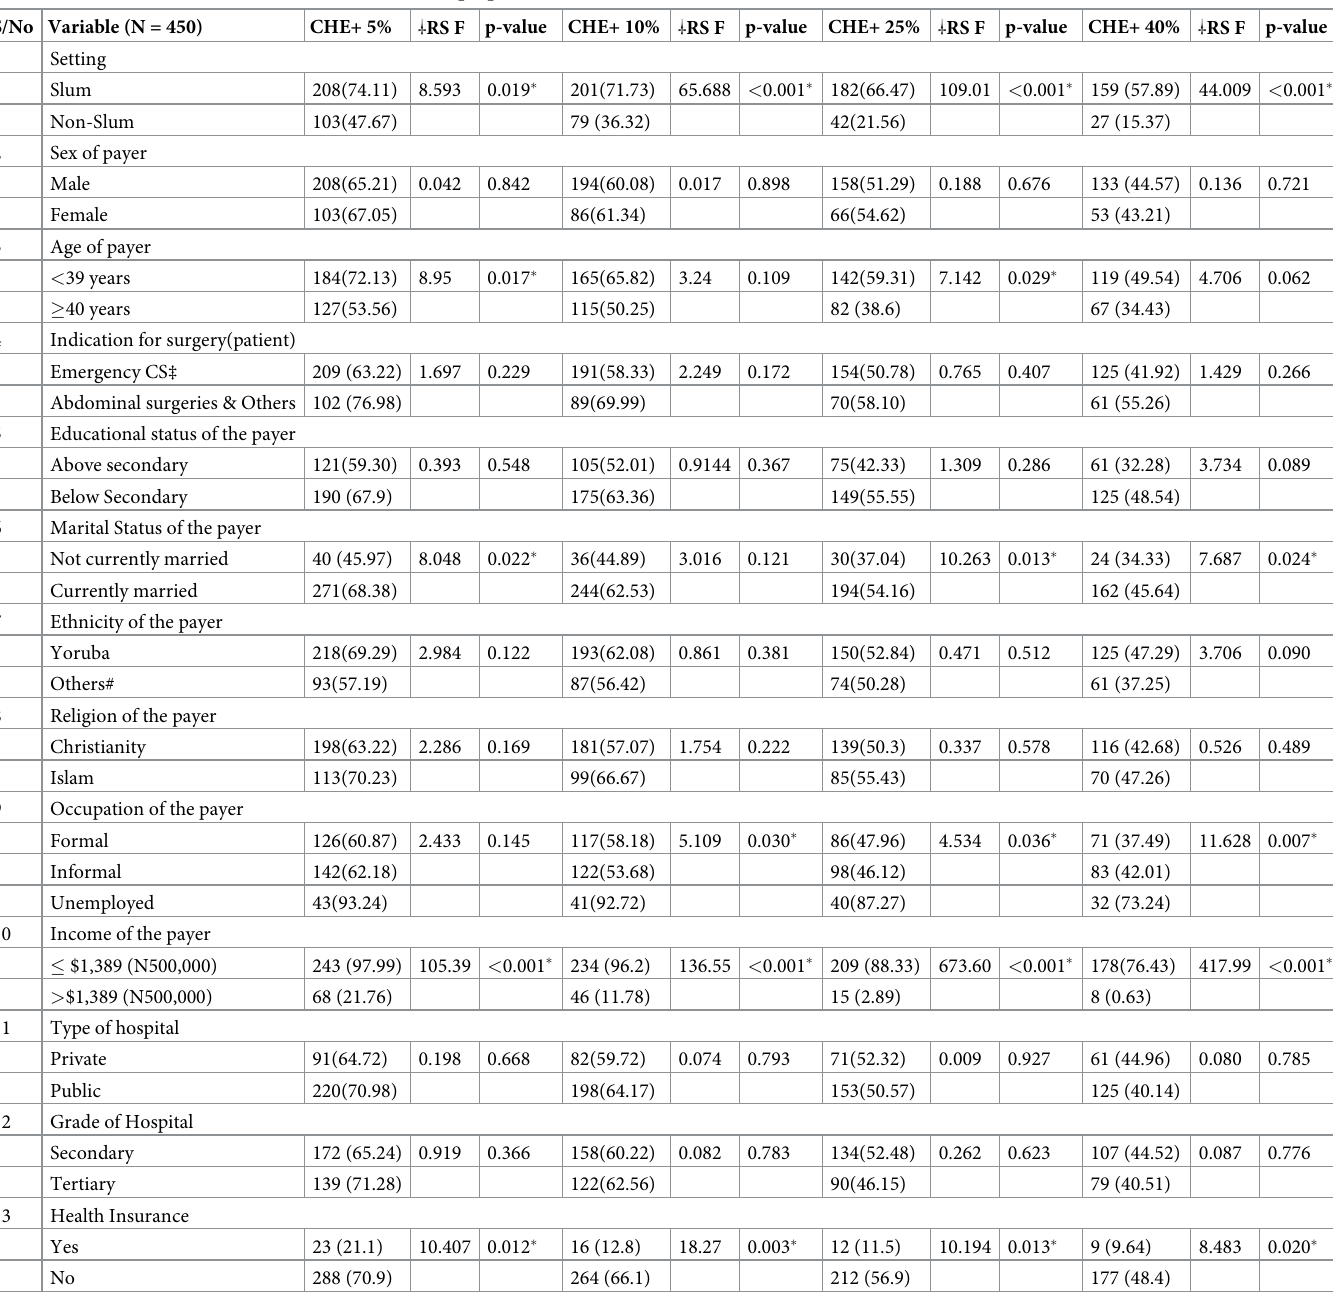
Table 2. Cross tabulation of selected characteristics and proportion of CHE at 5%, 10%, 25% and